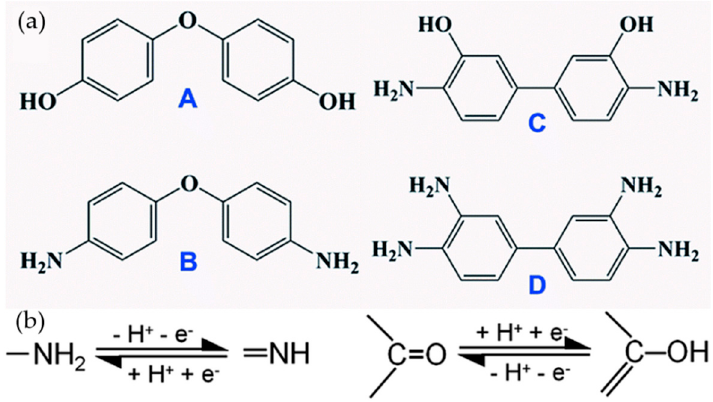
Figure 11. ( a ) Molecular structures of four types of small aromatic molecules; ( b ) The redox processes of amino and hydroxyl groups in H 2 SO 4 electrolyte. Reproduced with permission from [113]. The Royal Society of Chemistry